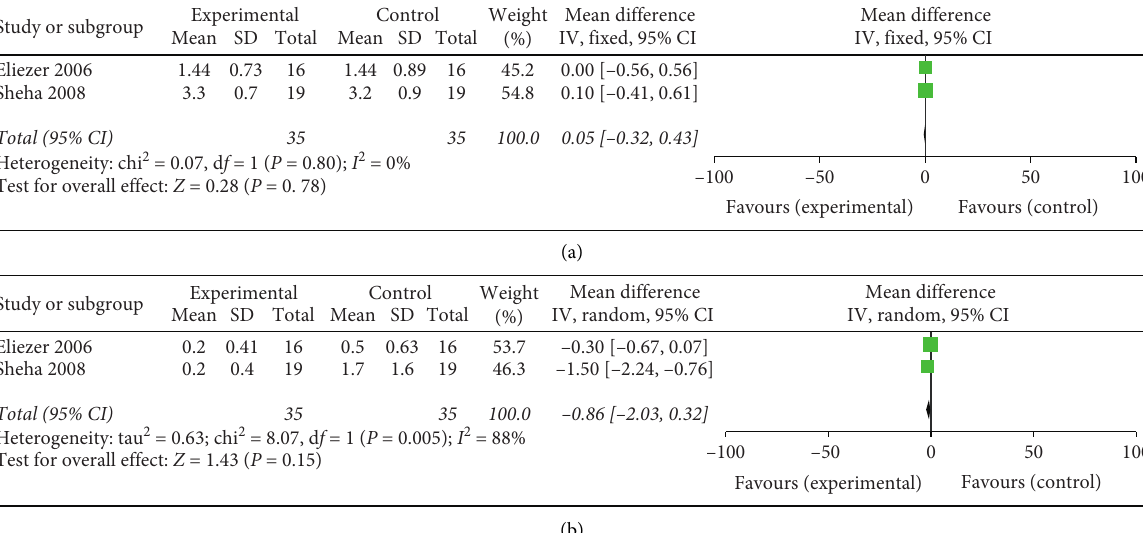
Figure 5: Forest plot comparison of the number of antiglaucoma medications after treatment in the AMT and control group (a) pre- operatively and (b) one year